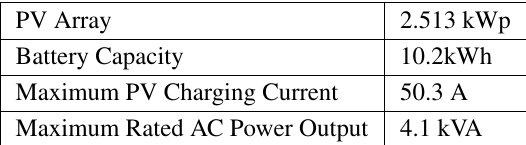
Table 4. PV Sizing Results for the WaterPumping